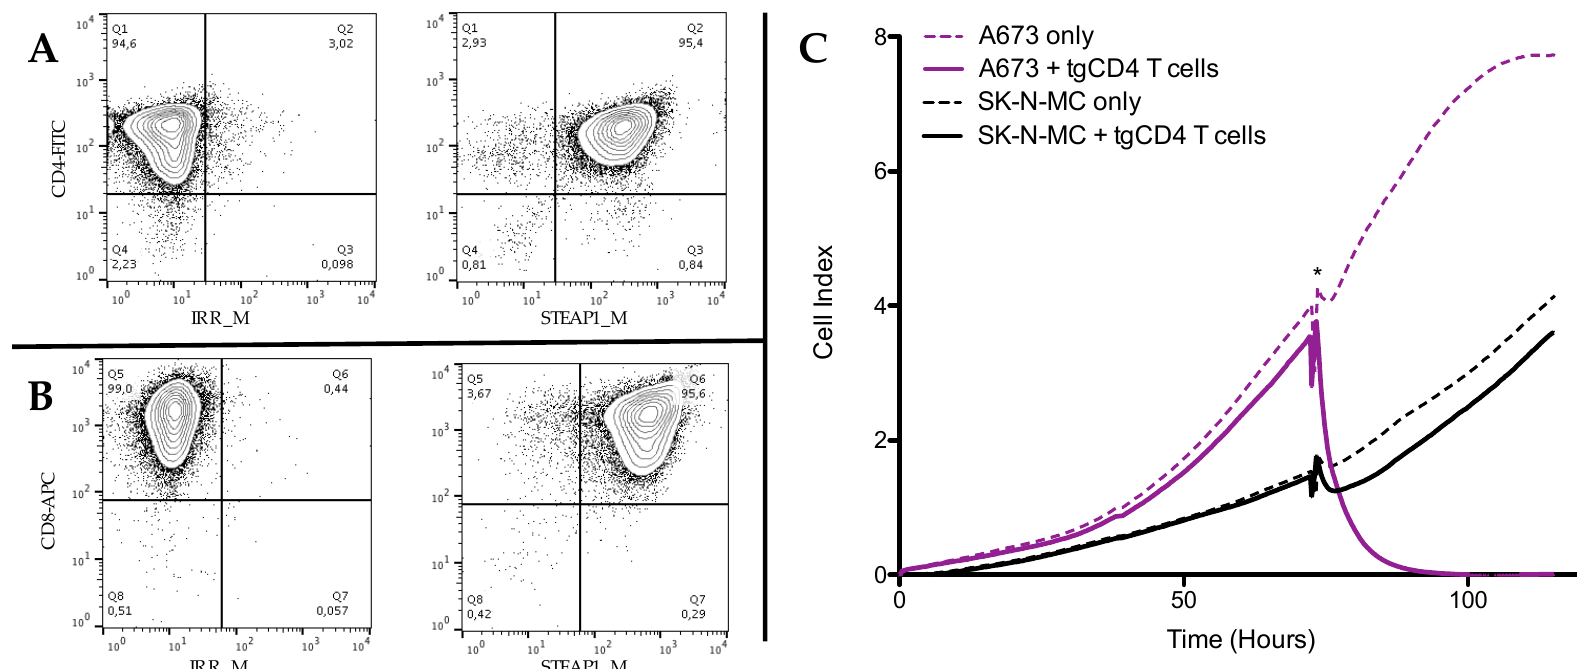
Figure 1. STEAP1 130 / HLA-A*02:01-specific TCR transgenic CD4 + (tgCD4) T cells and CD8 + (tgCD8) T cells of high purity were generated and tgCD4 cells showed specific antitumor activity in vitro. Contour plots of ( A ) STEAP1-specific tgCD4 cells, co-stained with CD4-FITC, irrelevant multimer-PE (IRR_M), relevant multimer-PE (STEAP1_M), and ( B ) STEAP1-specific tgCD8 cells, co-stained with CD8-APC, IRR_M, and STEAP1_M. ( C ) Contact dependent growth of A673 (HLA-A*02:01-positive) or SK-N-MC (HLA-A*02:01-negative) tumor cells was monitored in xCELLigence assay at e ff ector-to-target ratio 20:1 at day 46 of tgCD4 T cell culture. Addition of T cells / mock to pre-cultured tumor cells is asterisked (*). Specific target recognition by T cells resulted in growth inhibition (detachment) of A673 (purple) but not of SK-N-MC (negative control) in comparison to mock-treated A673 or SK-N-MC cells (dashed lines,